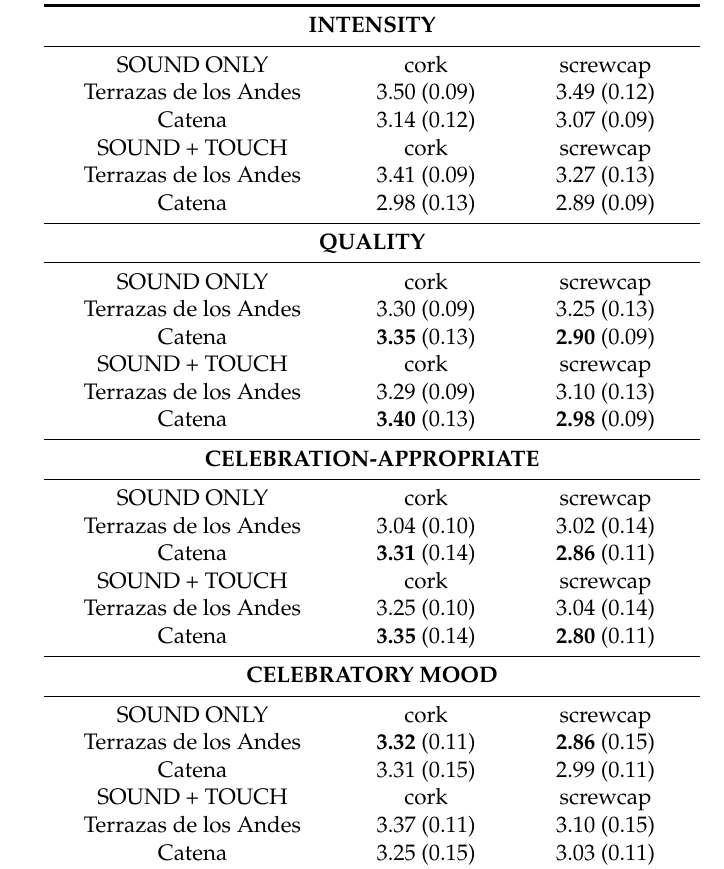
Table 5. Mean ratings of Bonferroni-corrected pairwise comparisons between conditions (standard error in parentheses). Bold typeface indicates significant difference between cork and screw-cap conditions ( p <